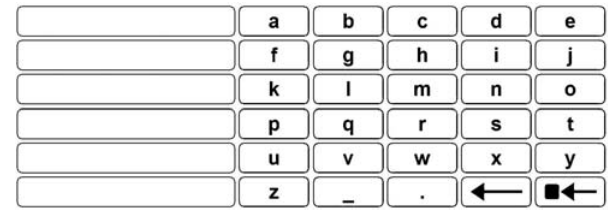
Figure 3. The scanning grid from The Grid 2 used in this comparison study (screenshot). The six long rectangles on the left hold word completions. The remaining options are fixed and include letters, an underscore for space, a period, a character-deletion function, and a word-deletion function.